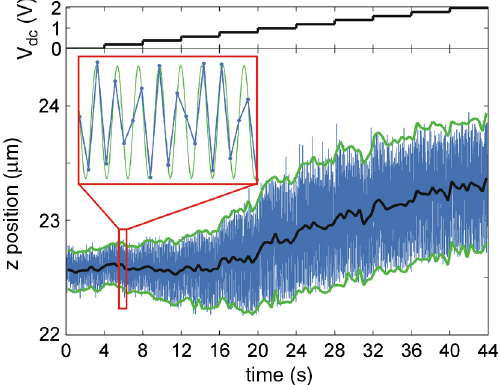
ac , normalized to